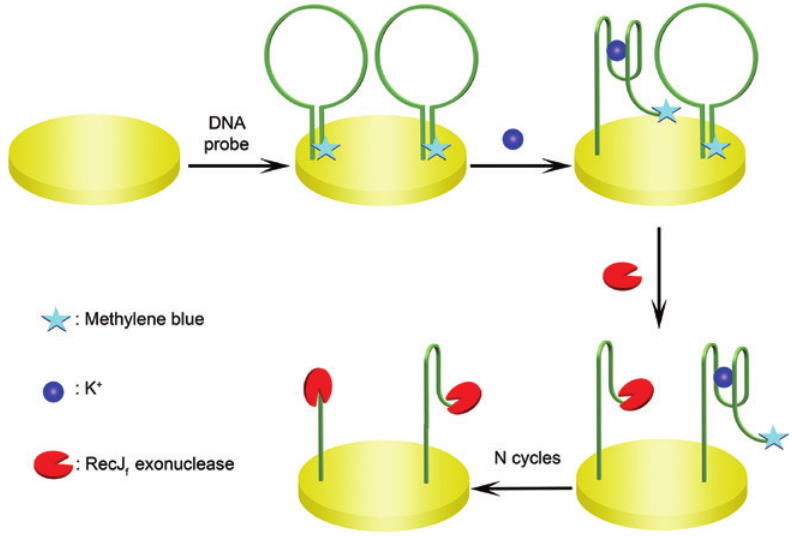
exonuclease cleavage. f